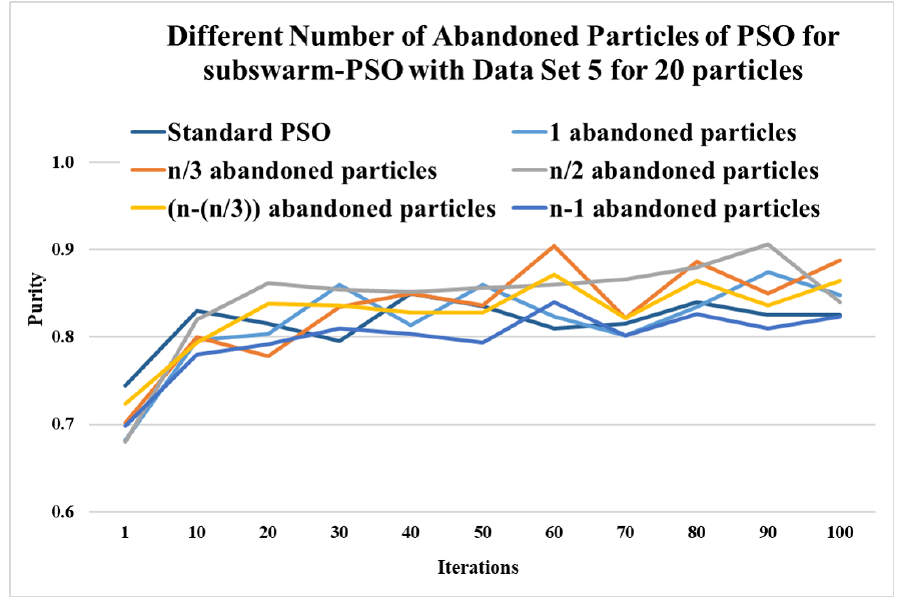
Figure 4. Comparison of the different number of abandoned particles of subswarm-PSO for data set 5 with 20